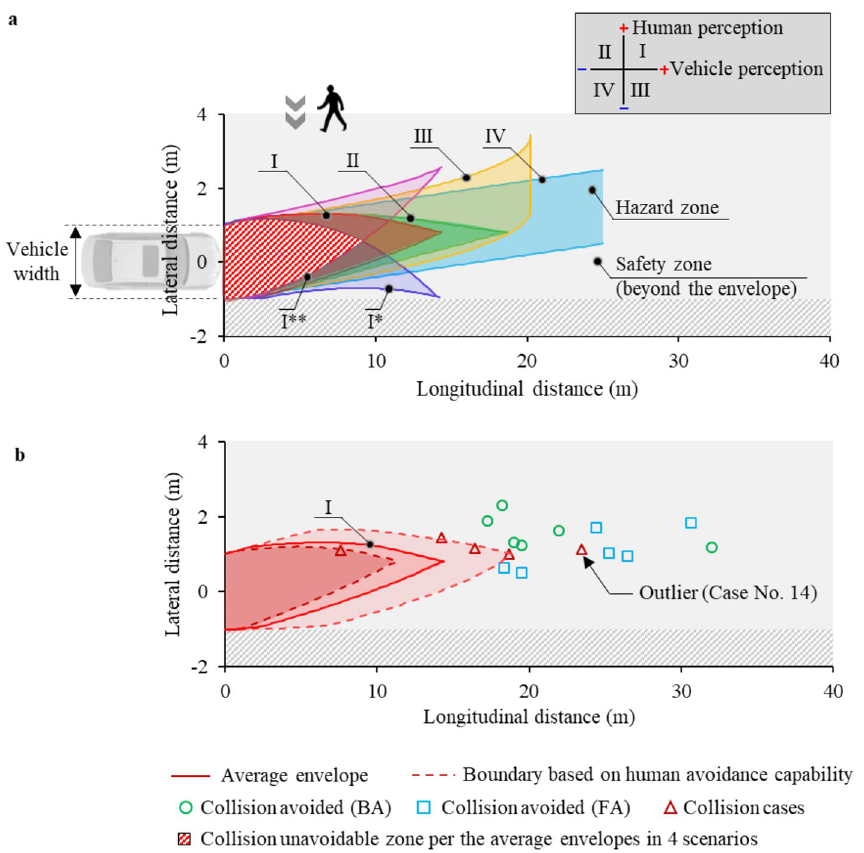
Figure 6. ( a ) Safety envelope of pedestrians upon vehicle collisions under different vehicle–pedestrian interaction conditions; the shaded hazard zones indicate the initial pedestrian locations where collisions are unavoidable with a normal driving vehicle; ( b ) safety boundary based on human avoidance